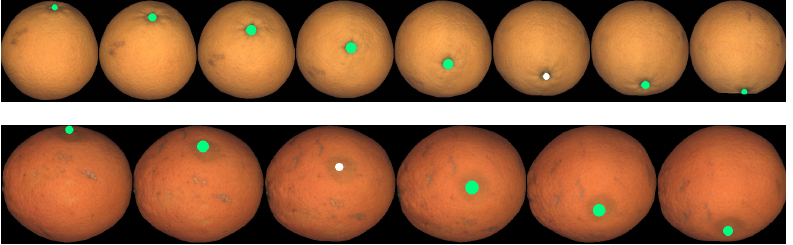
Figure 25. Example of point tracking in the case of two different tomatoes. The initial tracked point is white. Green circles mean predicted visible positions. The geometry model is set to oblate in this case. The sequence has been truncated to the views where the tracked point remains visible.